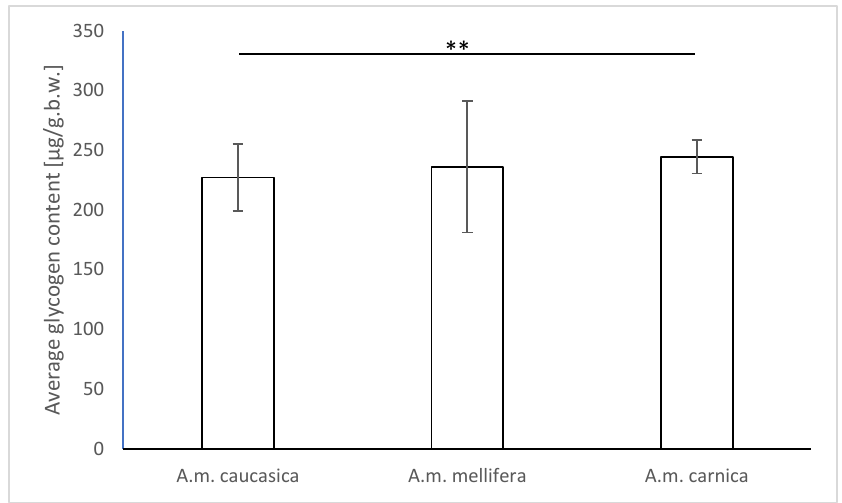
Figure 2. Differences between the average glycogen contents (in μg/g.b.w.) in the organisms of bees from the following subspecies: Caucasian honeybee, Carniolan honeybee and Central European honeybee. Statistical significance was determined (** p < 0.01;).